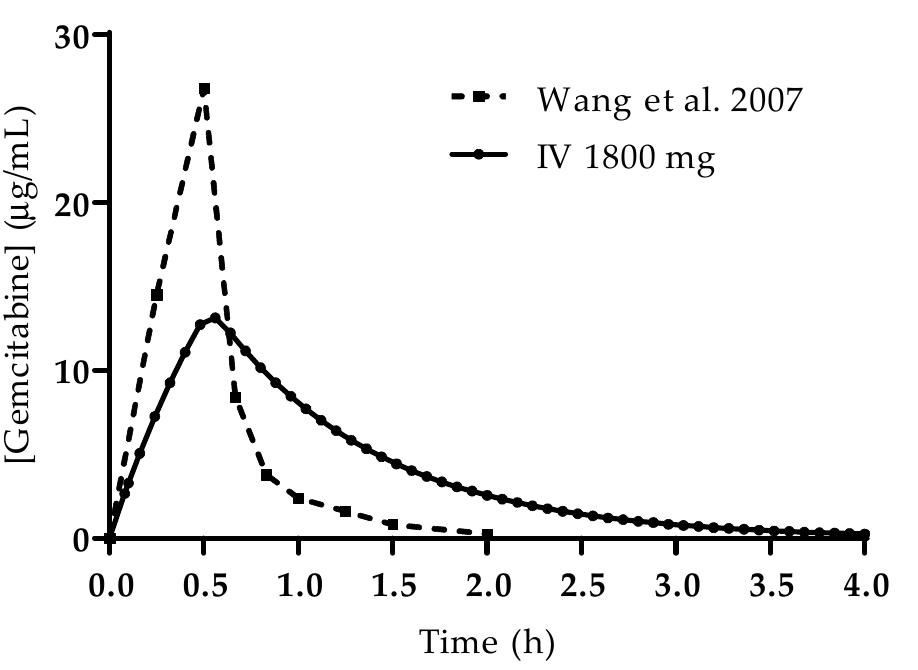
Figure 5. Comparison of the plasma concentration–time profiles from Wang et al. [19] (1200 mg/m 2 by 30 min IV infusion) and the profile acquired in the simulation carried out in this study (1800 mg by 30 min infusion).